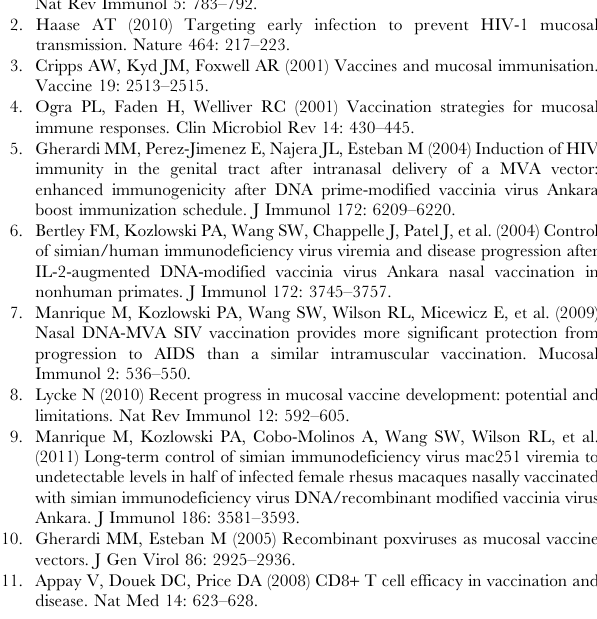
Figure S1 Evaluation of DNA-IL-12 adjuvant effect after intranasal immunization. Groups of four BALB/c mice were intranasally inoculated as described in the immunization schemes depicted at day zero all mice were DNA primed with the specified DNA vectors described for each group 14 days later all groups were boosted with MVA-EnvB (10 7 PFU/dose) (A). Ten days after the booster dose, specific cellular immune responses (IFN- c